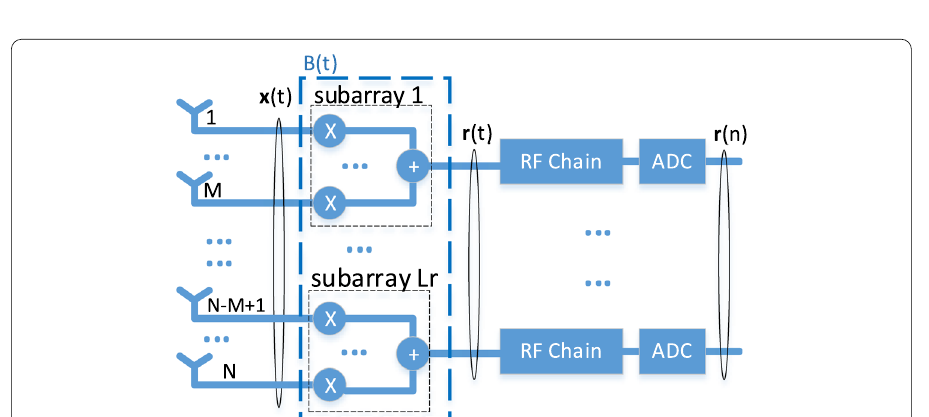
Fig. 2 The receiver in the partially connected hybrid